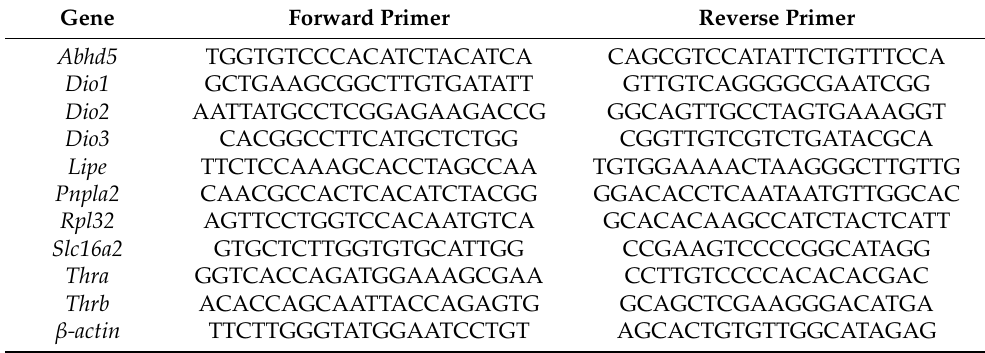
Table 2. Real-time PCR primers